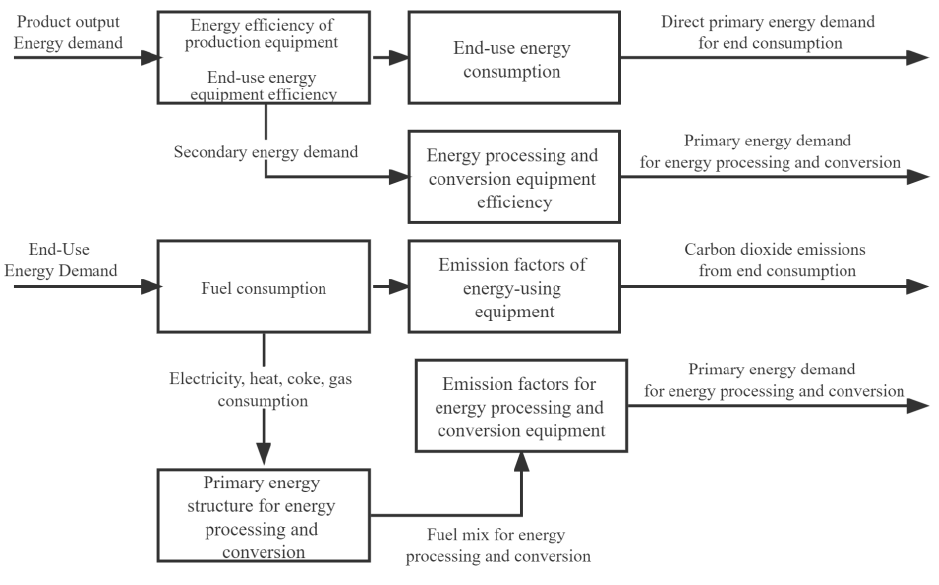
Figure 1. LEAP model technical route [19] .